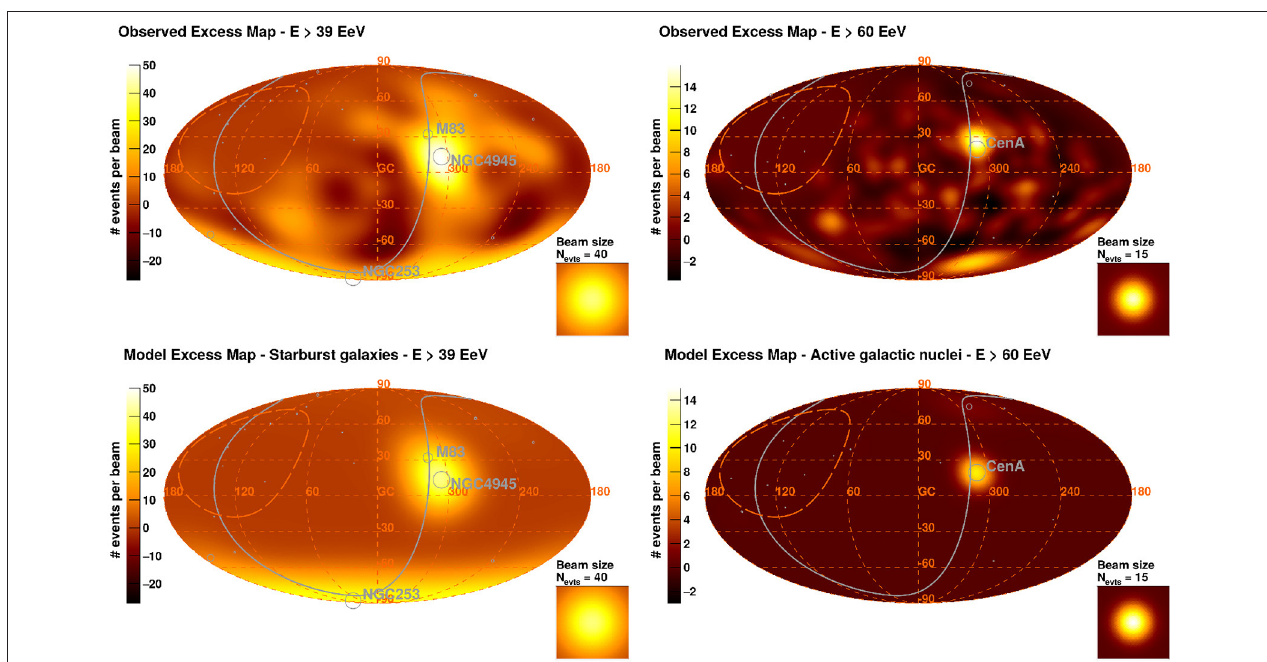
FIGURE 7 | (Top row) observed excess maps for E CR > 39EeV and E CR > 60EeV. (Bottom row) model excess maps for the SGB (left) and γ AGN model (right) at the same energy thresholds as above. The color scales indicate the number of events per smearing beam (see inset). The model flux map corresponds to a uniform full-sky exposure. The supergalactic plane is shown as a solid gray line. An orange dashed line delimits the field of view of the array (from Aab et al.,